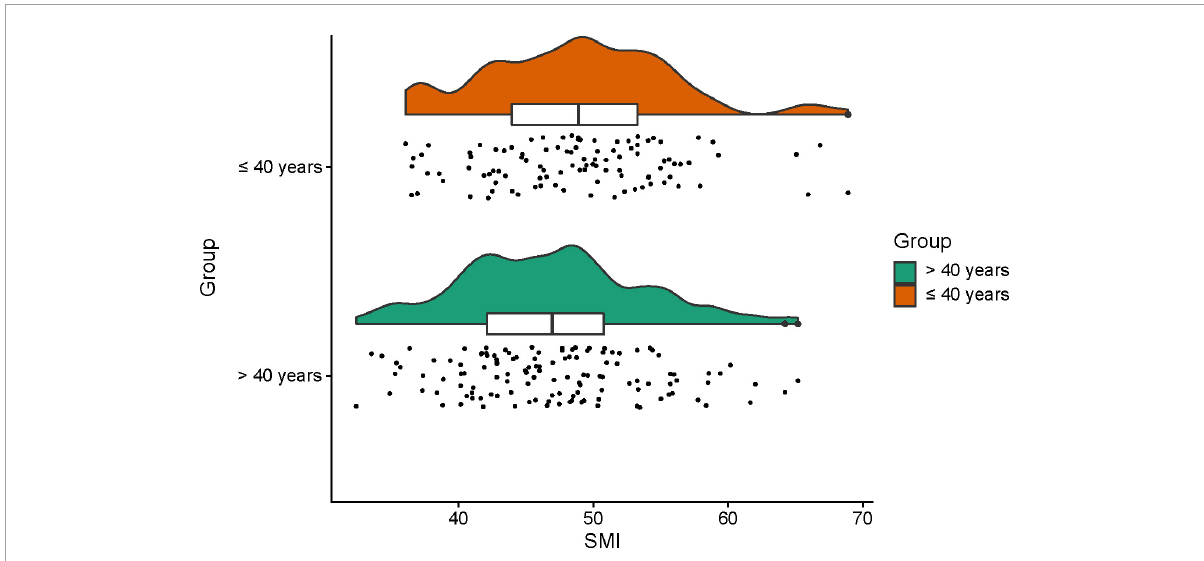
FIGURE3 The skeletal muscle mass index (SMI) in different age subgroups (age ≤ 40 years and age > 40 years) in male acute-on-chronic liver failure (ACLF)